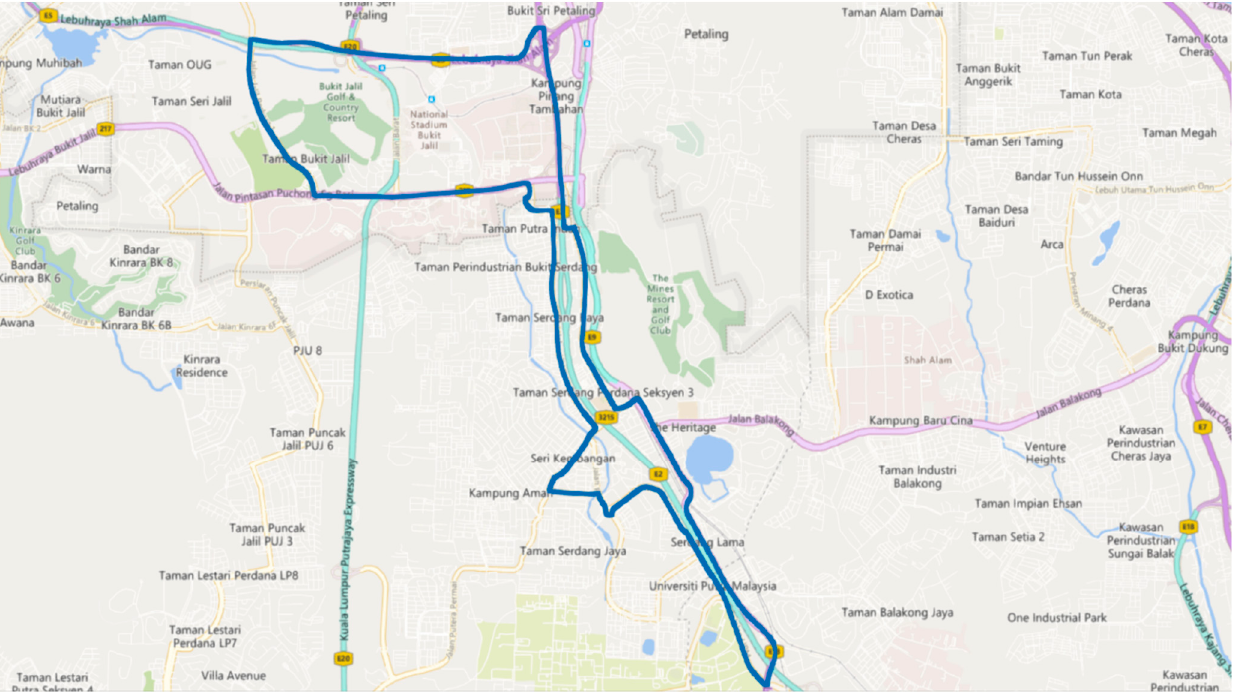
Figure 12. Selected test route.